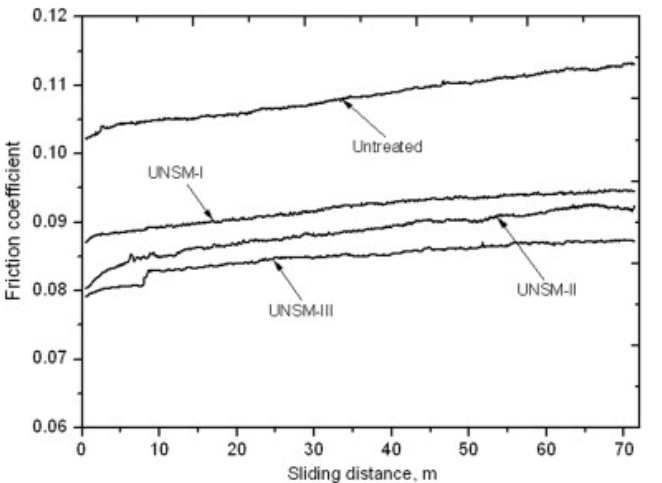
Figure 13. COF variation in untreated and UNSM’ed specimens. Reprinted with permission from ref. [56]. Copyright 2012, Elsevier. Table 1. Mechanical properties and microstructural features of USNM-treated substrate materials.